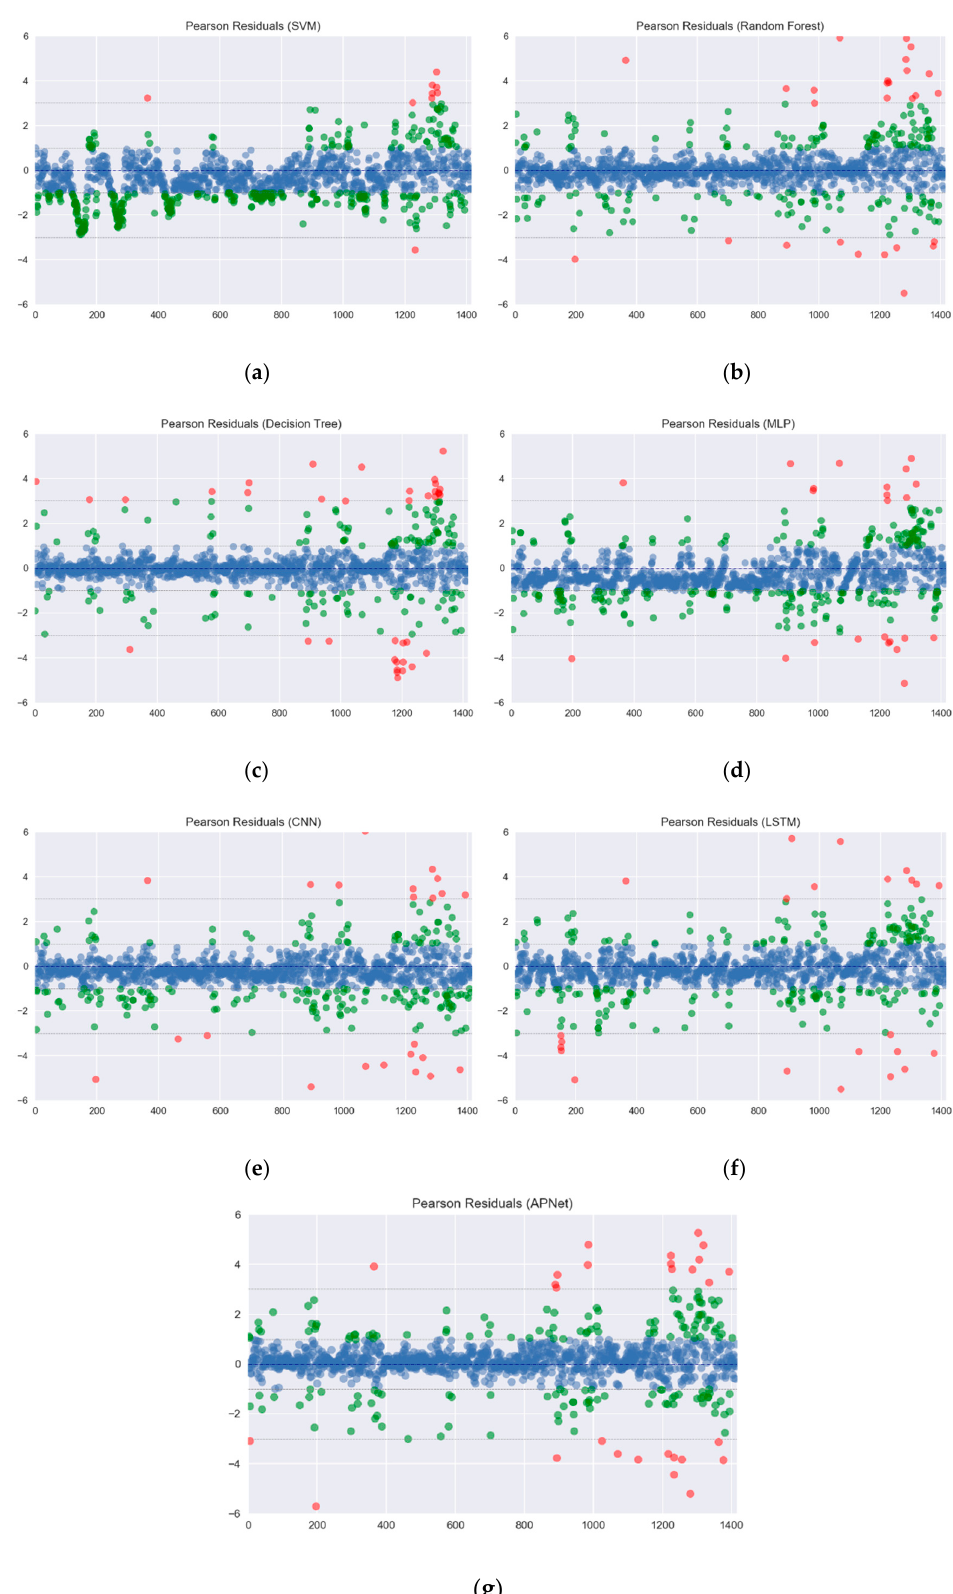
Figure 8. The Pearson residuals of all forecasting methods: ( a ) Partial results A; ( b ) Partial results B; ( c ) Partial results C; ( d ) Partial results D; ( e ) Partial results E; ( f ) Partial results F; ( g ) Partial results G.